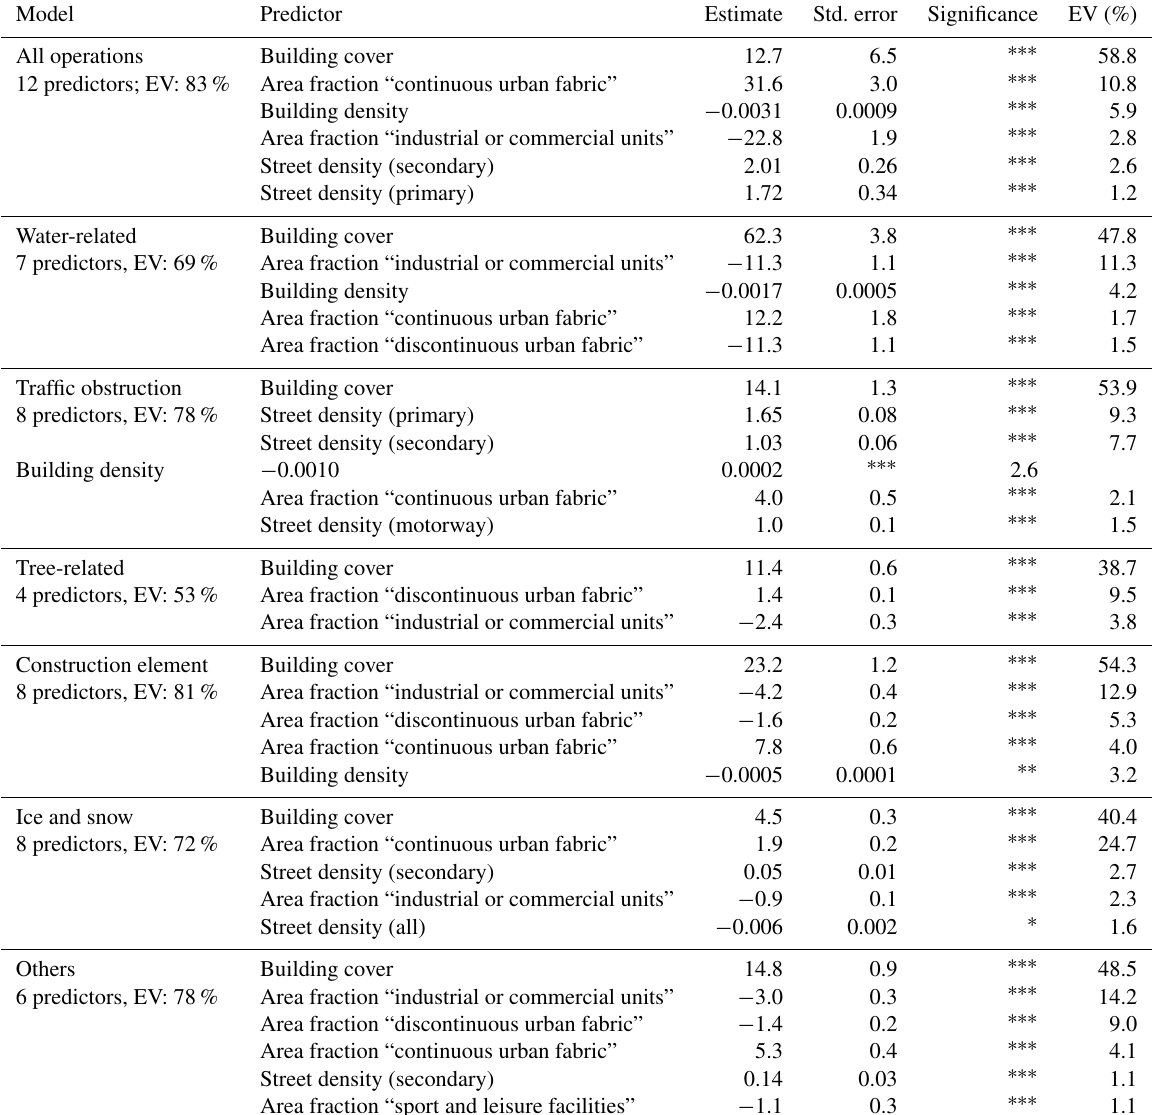
Table 4. Resulting optimal models. First column indicates the number of predictors as well as the total explained variation (EV) of the chosen optimal model (according to the cross-validation error). The leading predictors of each model are shown indicating weather a positive ( + ) or negative effect ( − ) is found. In the last column, EV in percent is given for these leading predictors. Within the table, predictors are shown if they have an EV >